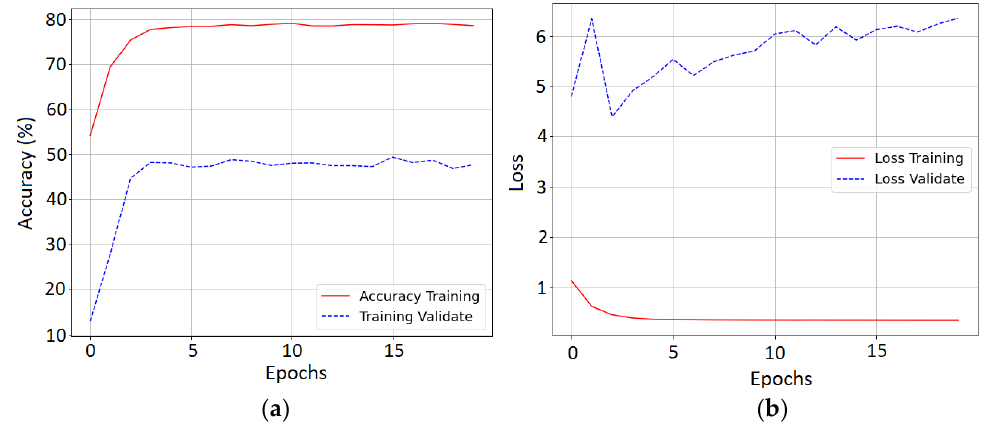
Figure 5. Training record of the ResNet-50 model. ( a ) Training accuracy, ( b ) Training loss.